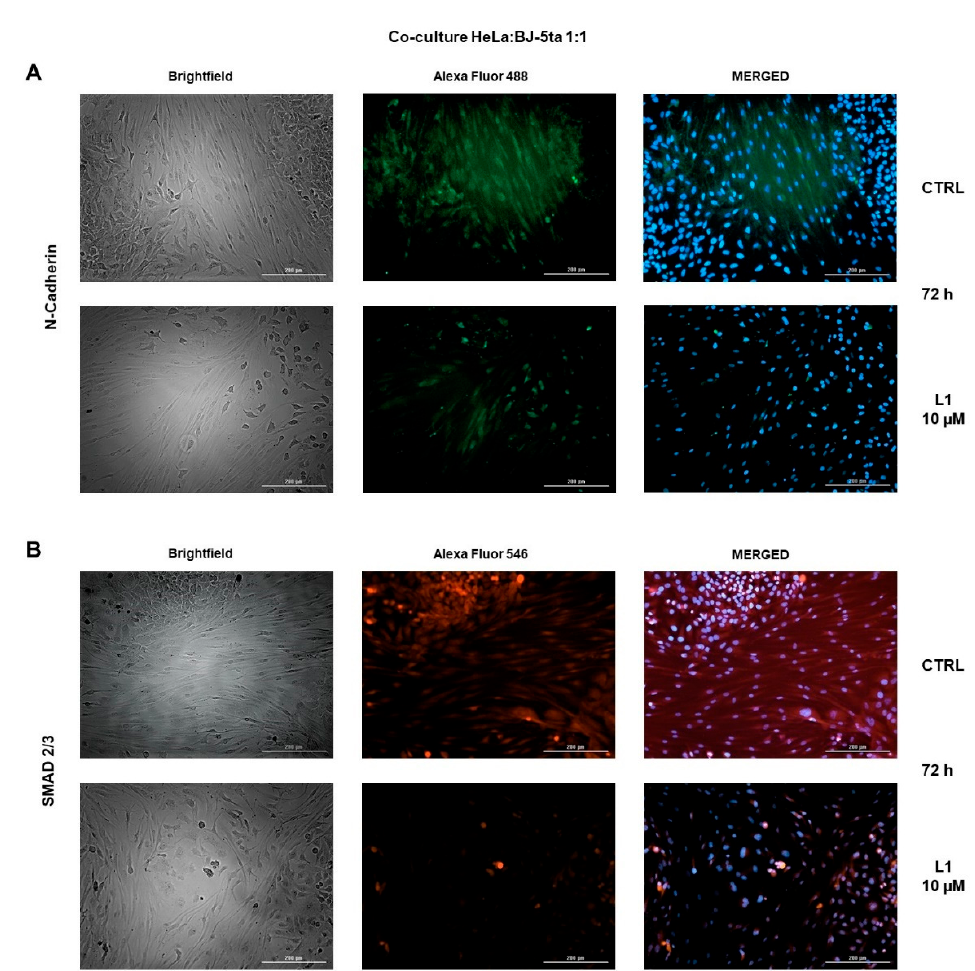
Figure 12. Representative HeLa and BJ-5ta co-culture staining pictures of N-Cadherin ( A ) and Smad2/3 ( B ) proteins at 72 h captured by live cell imaging.